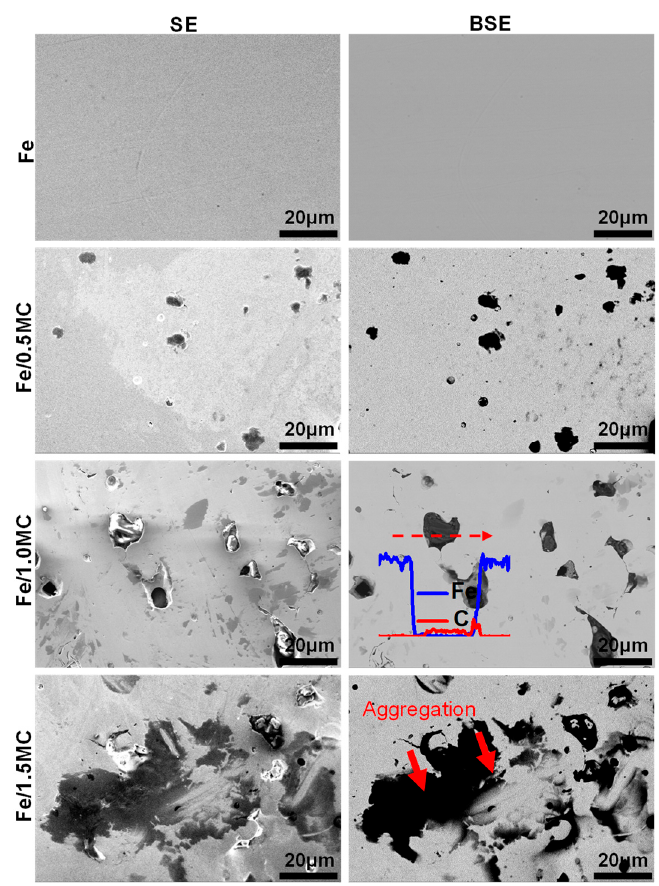
Figure 2. Secondary electron (SE) and back-scattered (BSE) images showed the microstructure of as-built Fe and Fe/MC composites.